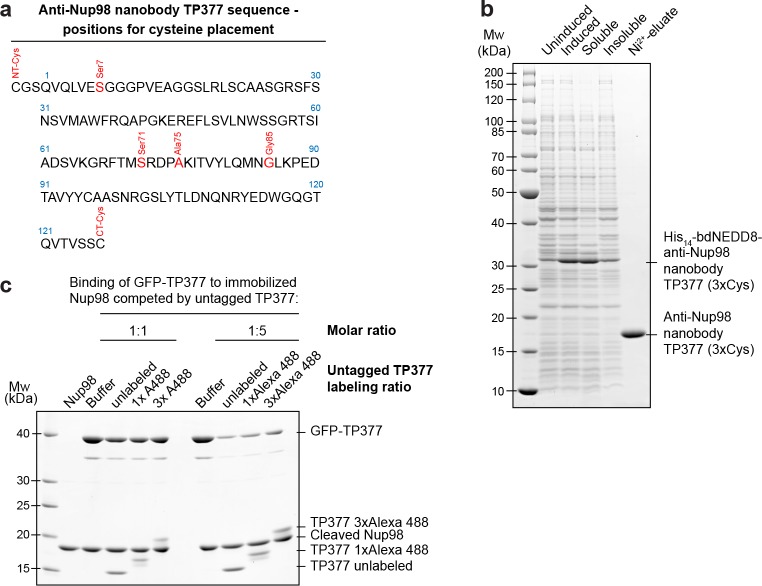
Expression and relative affinity of anti-Nup98 nanobody TP377 with engineered surface cysteines.(a) Amino acid sequence of anti-Nup98 nanobody TP377 illustrating the positions chosen for mutation to cysteine (red). (b) SDS–PAGE and Coomassie staining showing the expression and purification of TP377 with three engineered cysteines (NT-Cys, Ser7Cys, CT-Cys) in the Escherichia coli cytoplasm. Single-step purification was performed using Ni2+ chelate affinity chromatography and cleavage using the bdNEDP1 protease. (c) Relative affinity of TP377 with different labeling ratio to Nup98716-866. GFP-tagged TP377 was incubated with biotinylated His14-Avi-bdSUMO-tagged Nup98716-866 immobilized on Streptavidin agarose. For competition, unlabeled, 1x or 3x Alexa Fluor 488-labeled TP377 was added in equimolar amount or fivefold molar excess relative to GFP-TP377. Bound nanobodies were eluted by bdSEN1P cleavage and analyzed by SDS–PAGE followed by Coomassie staining.